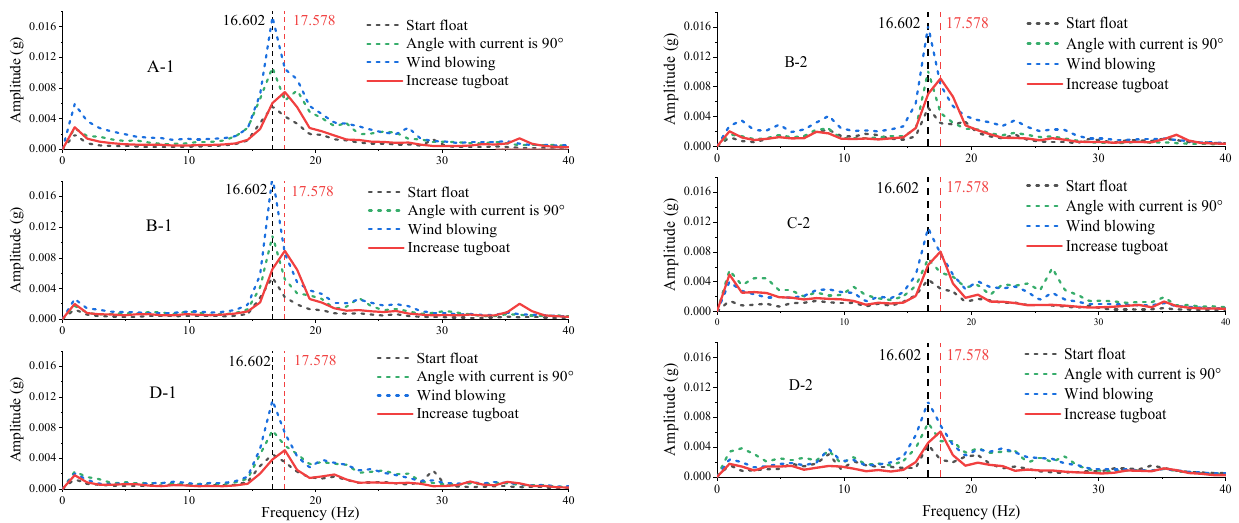
Figure 13. Frequency spectrum of pipeline segment 2 floating transport.